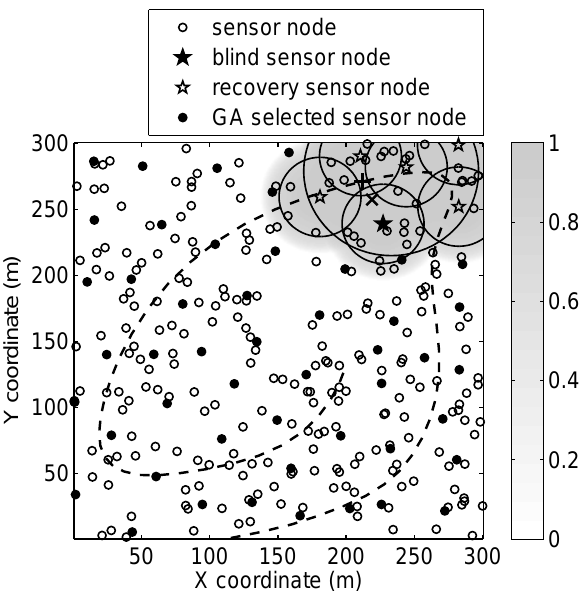
Figure 8 . Recovery mechanism to find the missing target.